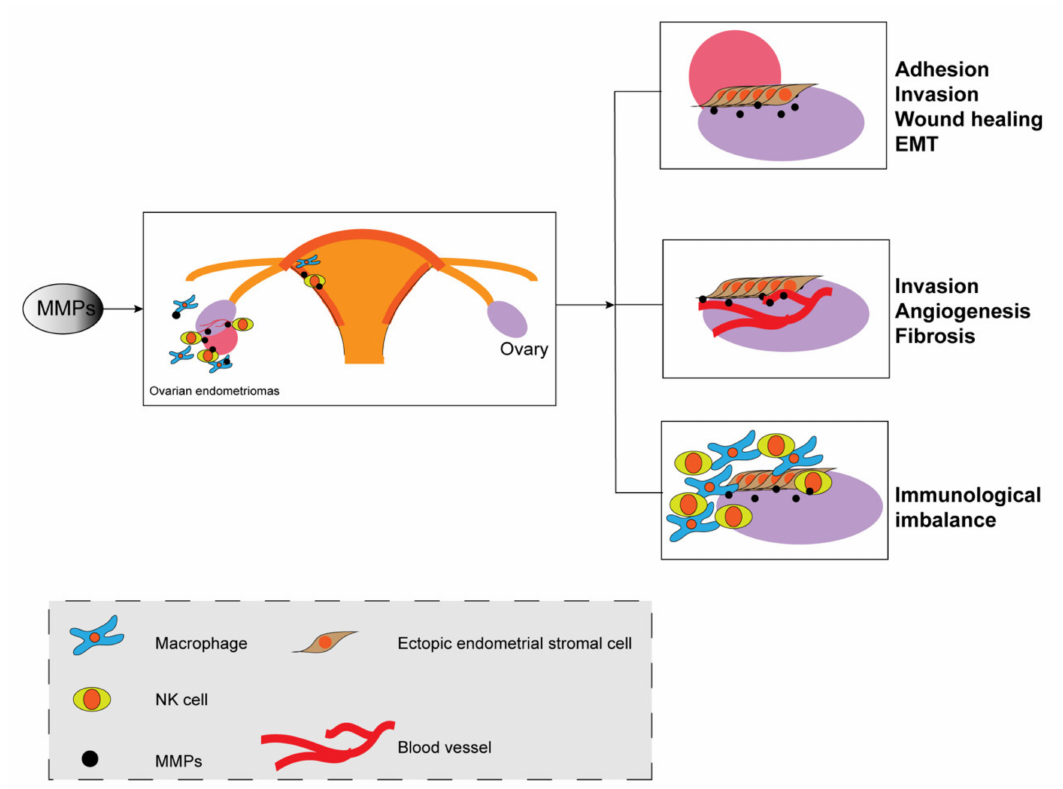
Figure 2. The role of MMPs in the pathophysiology of endometriosis. In endometriosis, MMPs play a key role in various pathophysiological processes. The endometrium is shed during menstruation due to the fluctuation of hormones, and MMPs then accelerate the growth of the new endometrium to cover the wound. Free endometriotic cells pass through the fallopian tube; adhere to the surfaces of the peritoneum, ovary,